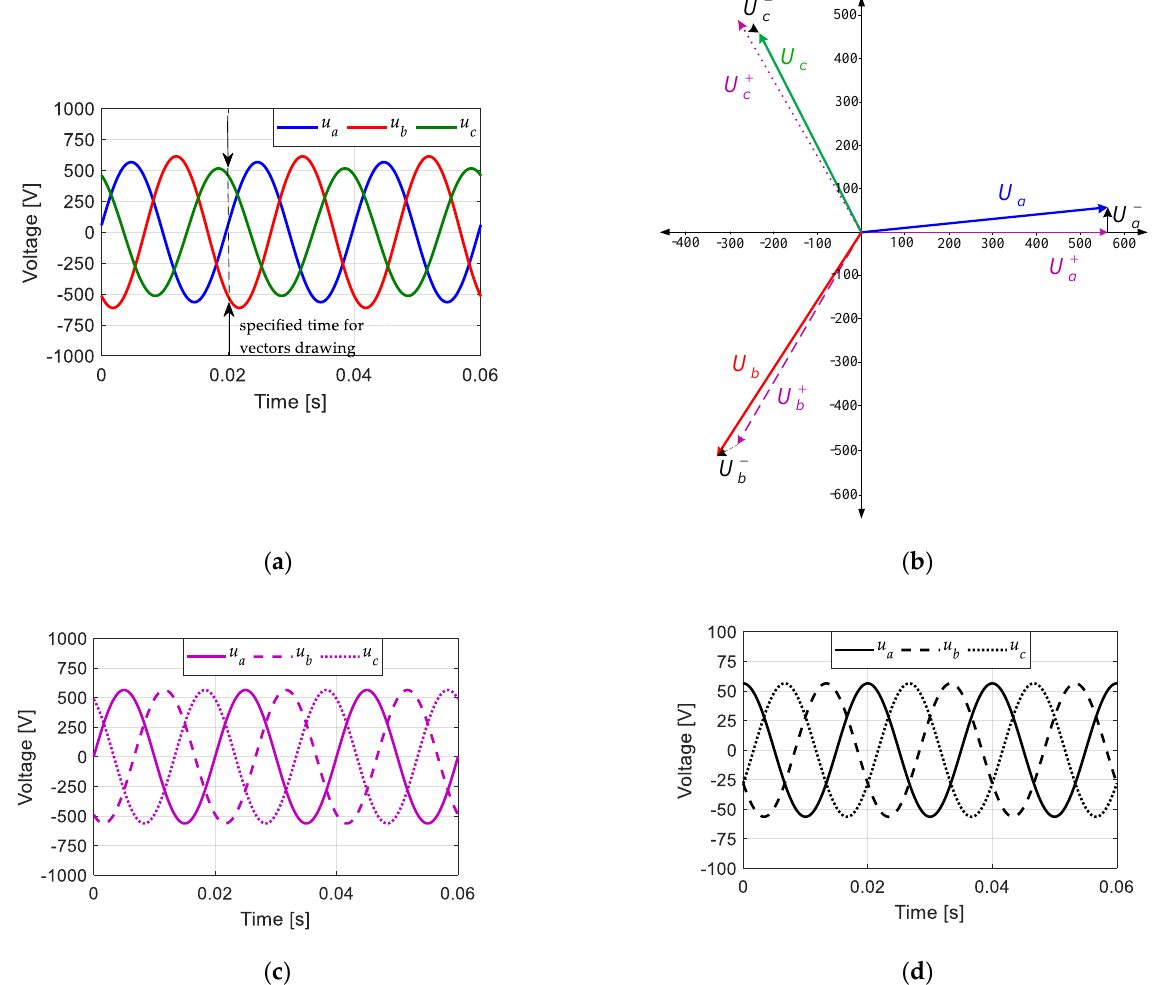
Figure 3. ( a ) Three-phase unbalanced voltages instantaneous values with 10% Voltage Unbalance Factor (VUF), ( b ) three-phase vector diagram of the distorted waveform, ( c ) positive sequence, and ( d ) negative sequence. Negative sequence voltage magnitudes are 10% of positive counterparts at the same frequency.